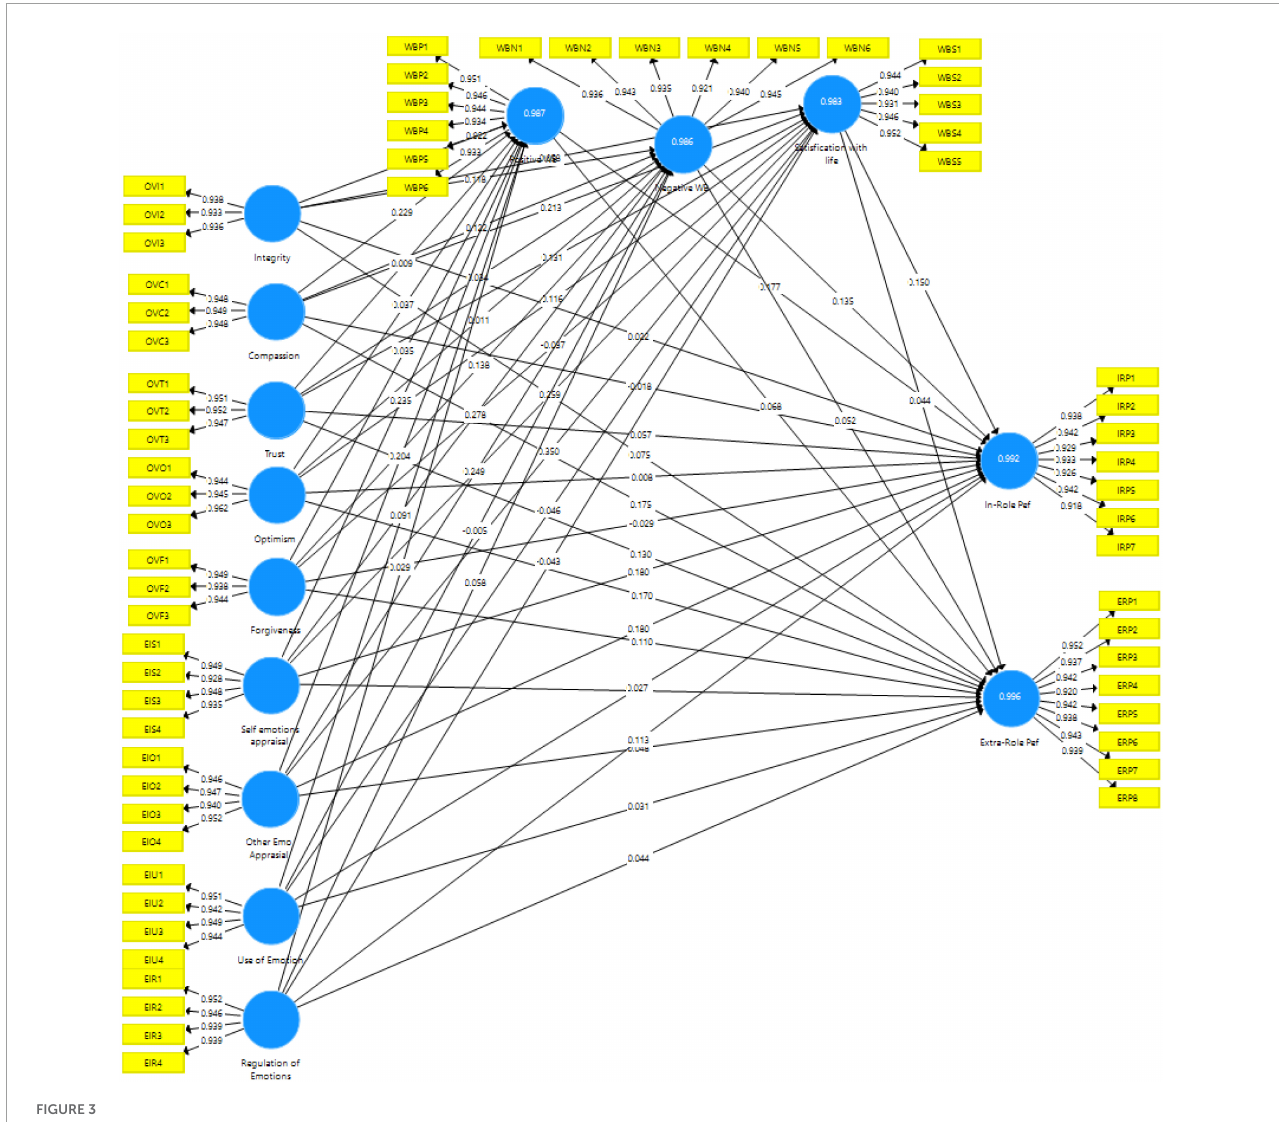
FIGURE3 First order measurement